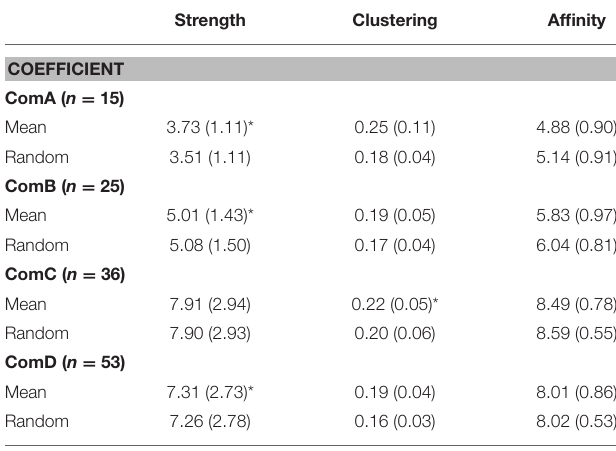
TABLE 4 | Average strength, clustering coefficients, and affinity with comparisons from random calculating using half-weight indices for individuals sighted at least five